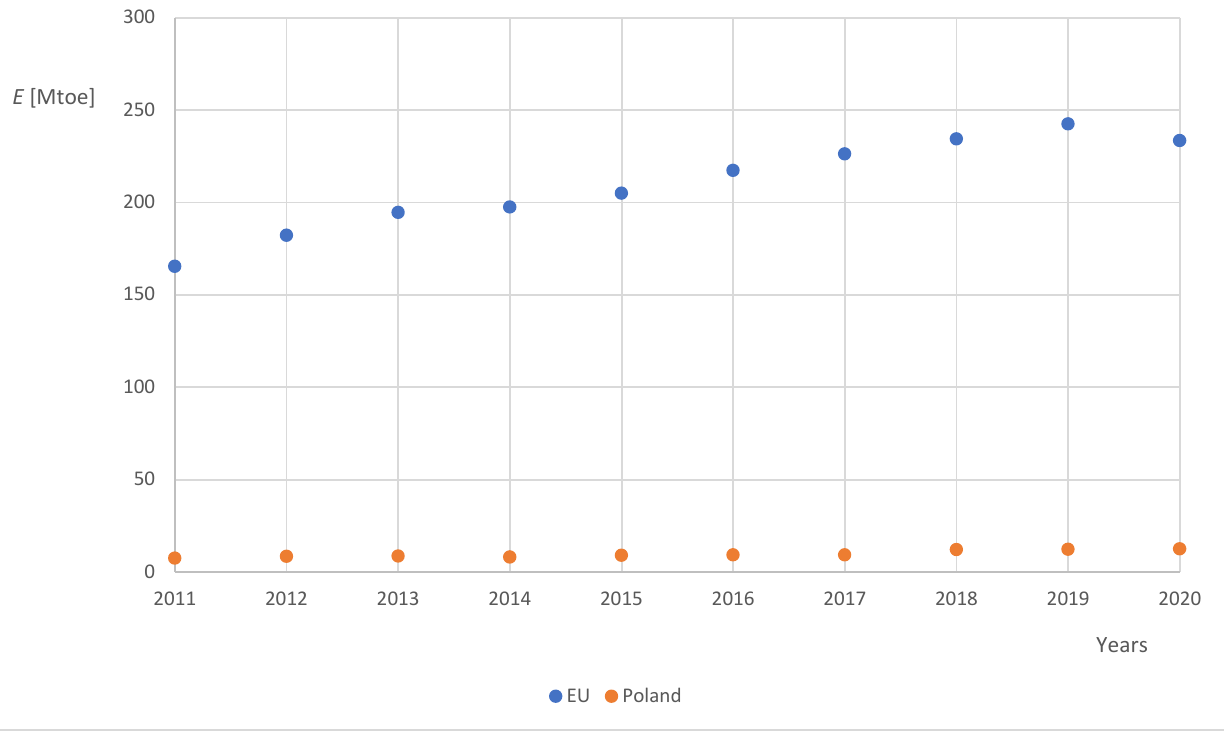
Figure 4. Obtaining primary energy from renewable sources in the EU and Poland, according to Table 18 (own elaboration).